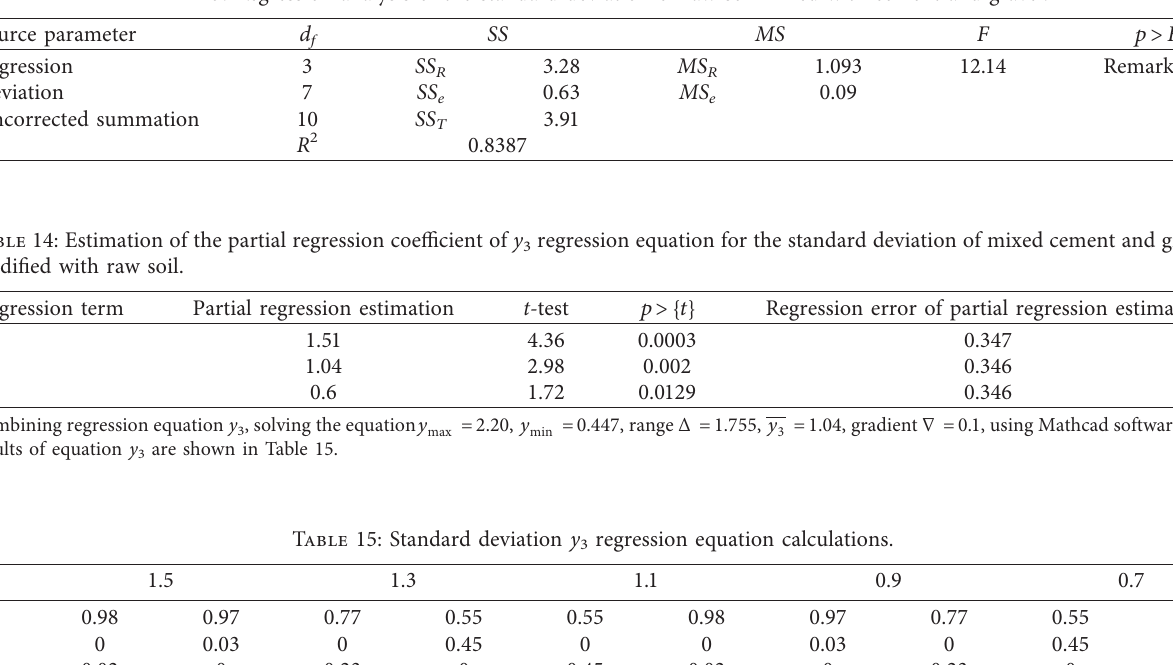
Figure 5: Isogram of peak displacement y Table 13: Regression analysis of the standard deviation of raw soil mixed with cement and gravel.